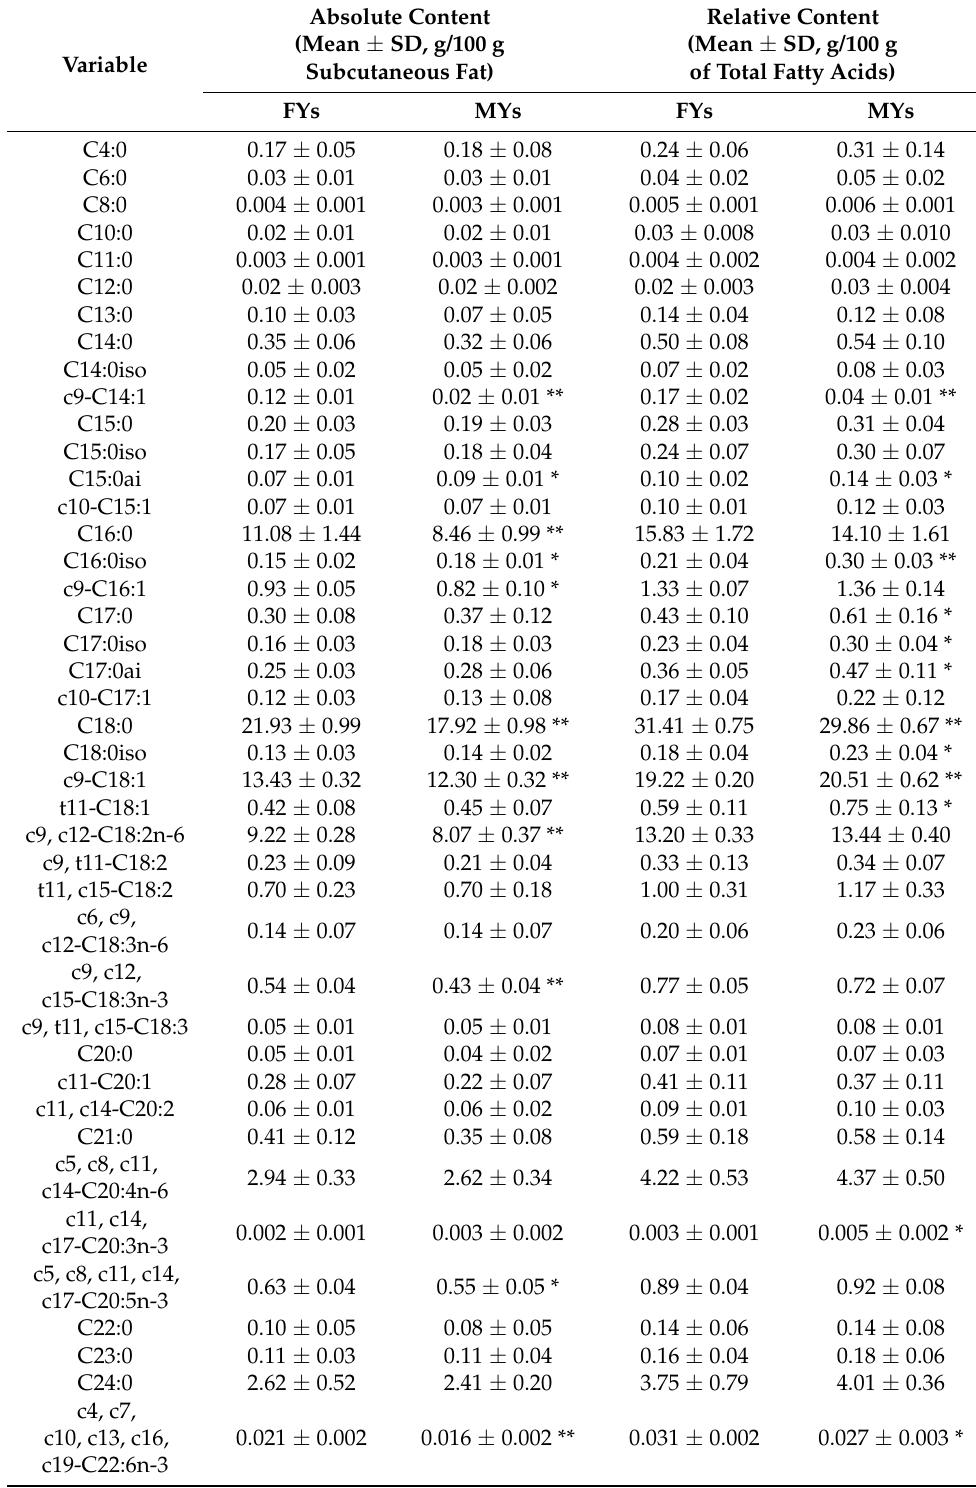
Table 2. The absolute and relative content of fatty acids in the subcutaneous fat of female yaks (FYs, n = 6) and male yaks (MYs, n =